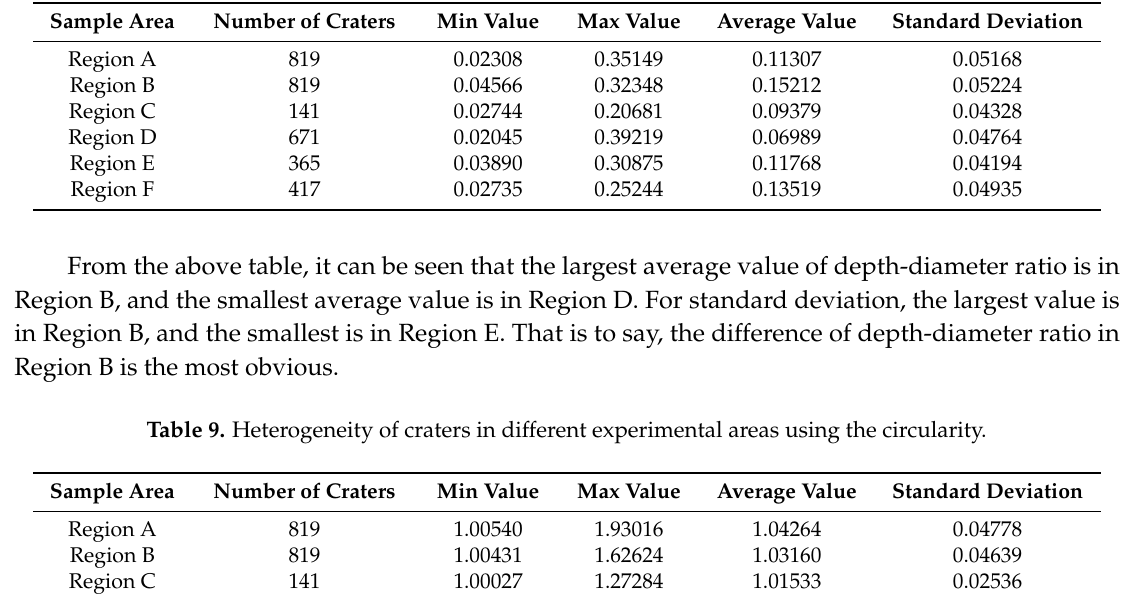
Table 8. Heterogeneity of craters in different experimental areas using the depth-diameter ratio.